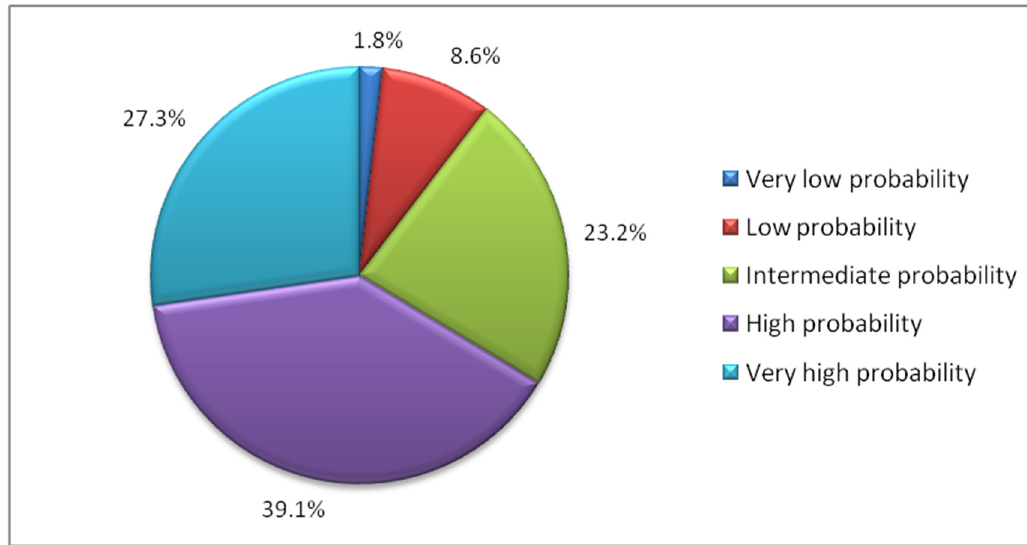
Figure 3. Distribution of the sample according to the groups of predicted probability of recovery.